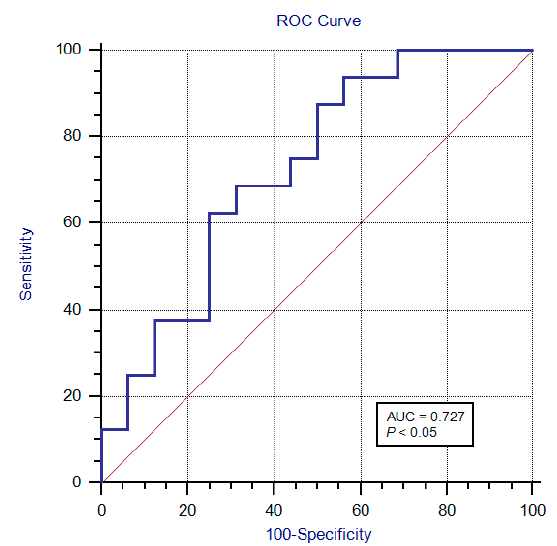
Figure 4. The area under the ROC curve (AUC) was 0.727 (95% confidence interval [CI]: 0.541–0.868) when the SWE values were used for prediction of DFU in patients with DPN. When the best cutoff value of SWE was 24.48 kPa for prediction of DFU, the sensitivity and specificity were 62.50% (95% CI: 35.4–84.8%) and 75% (95% CI: 47.6–92.7%), respectively.